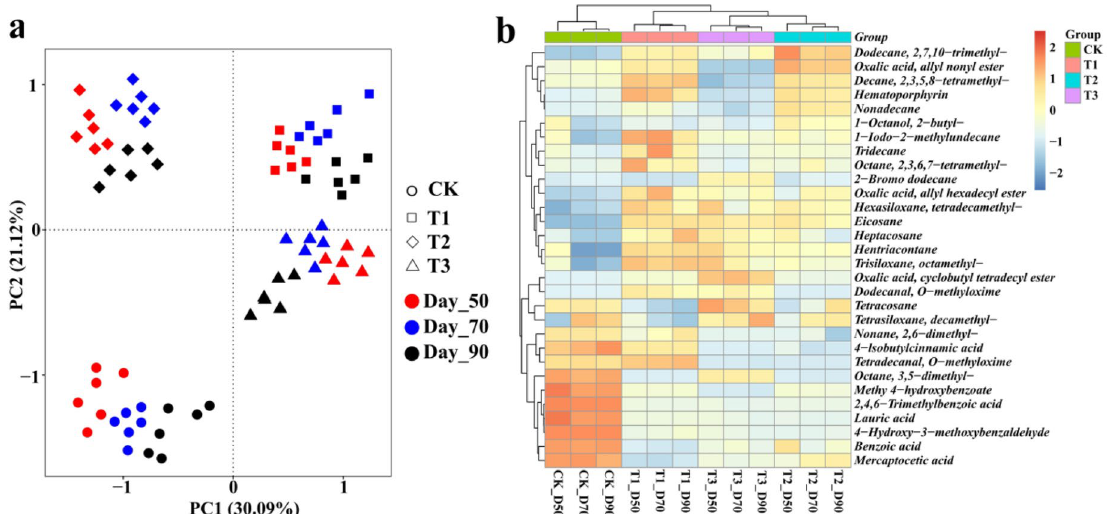
Figure 4. (a) Principal component analysis (PCA) of metabolites analyzed from the four treatments soil at 50 days, 70 days and 90 days post-transplanted, respectively. (b) Heatmap showing top 30 most significant metabolites from soil samples of four treatments at 50 days, 70 days and 90 days post-transplanted. (CK: the control group, T1: marigold powder mix with B. amyloliquefaciens ZM9 group, T2: B. amyloliquefaciens ZM9 group, T3: marigold